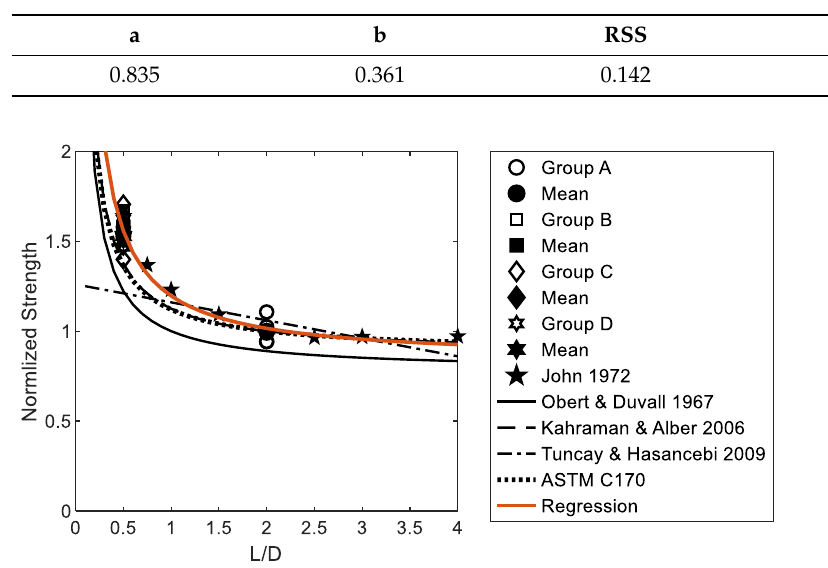
Figure 16. Normalized strength with empirical